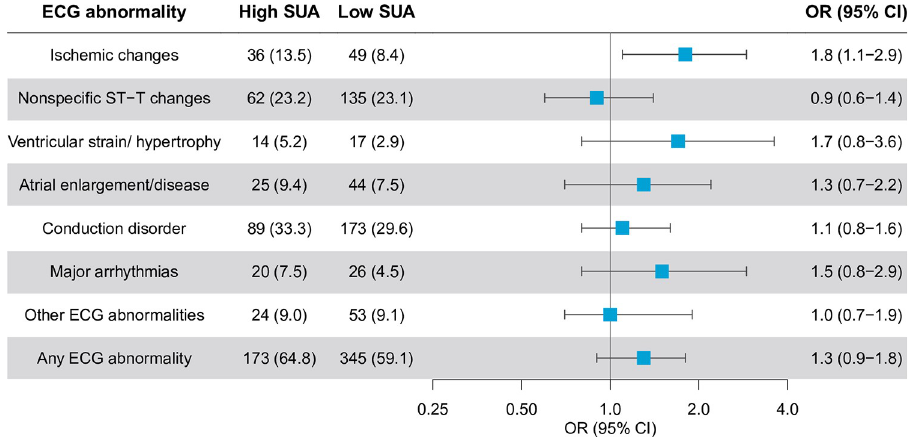
Fig 1. Odds Ratios for the association between upper tertile of sex-specific serum uric acid and ECG abnormalities. Multivariable a logistic regression analysis. a Adjusted for age, sex, origin, physical activity, low eGFR, systolic blood pressure, fasting glucose, total cholesterol, current smoking, past MI, high serum uric acid.